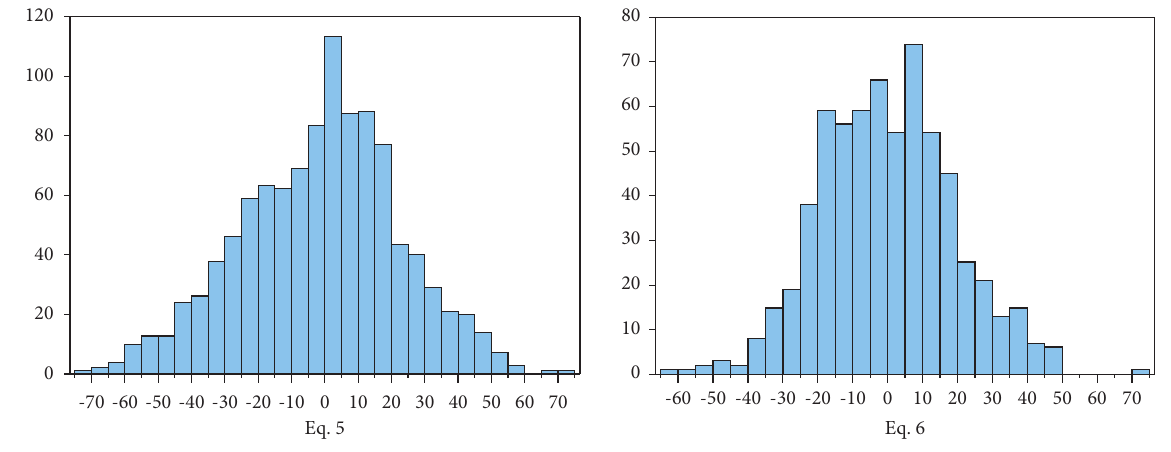
Figure 1: Normality test of the error terms of the models. Table 6: The results of the first hypothesis with the random effect Table 7: The results of the second hypothesis with the random model. effect